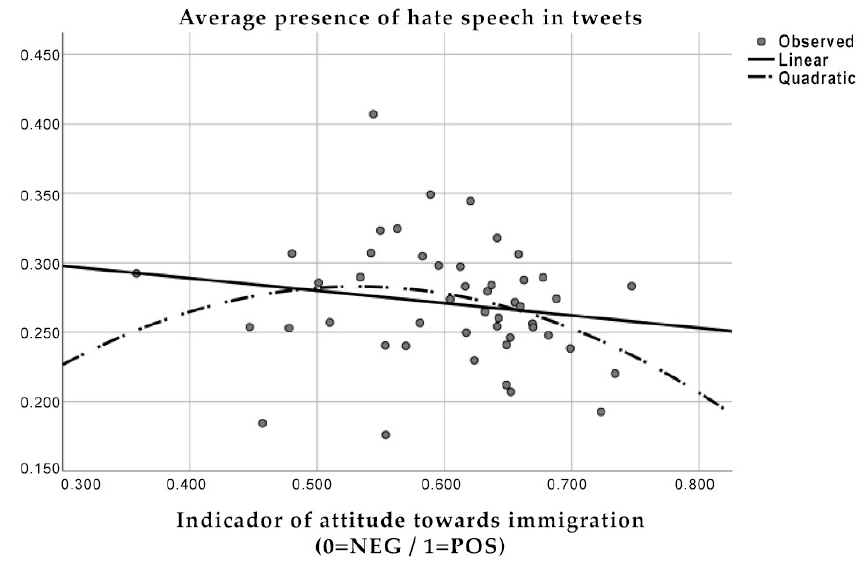
Figure 7. Scatter plot. Correlation between the attitude towards immigration and the level of hate speech found on Twitter. Own